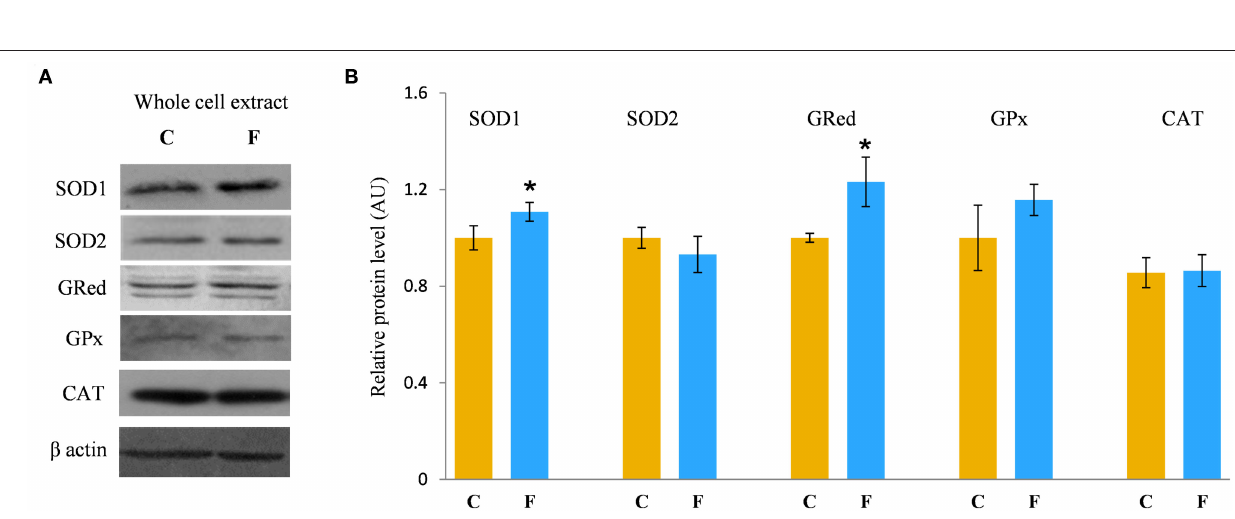
Frontiers in Nutrition |